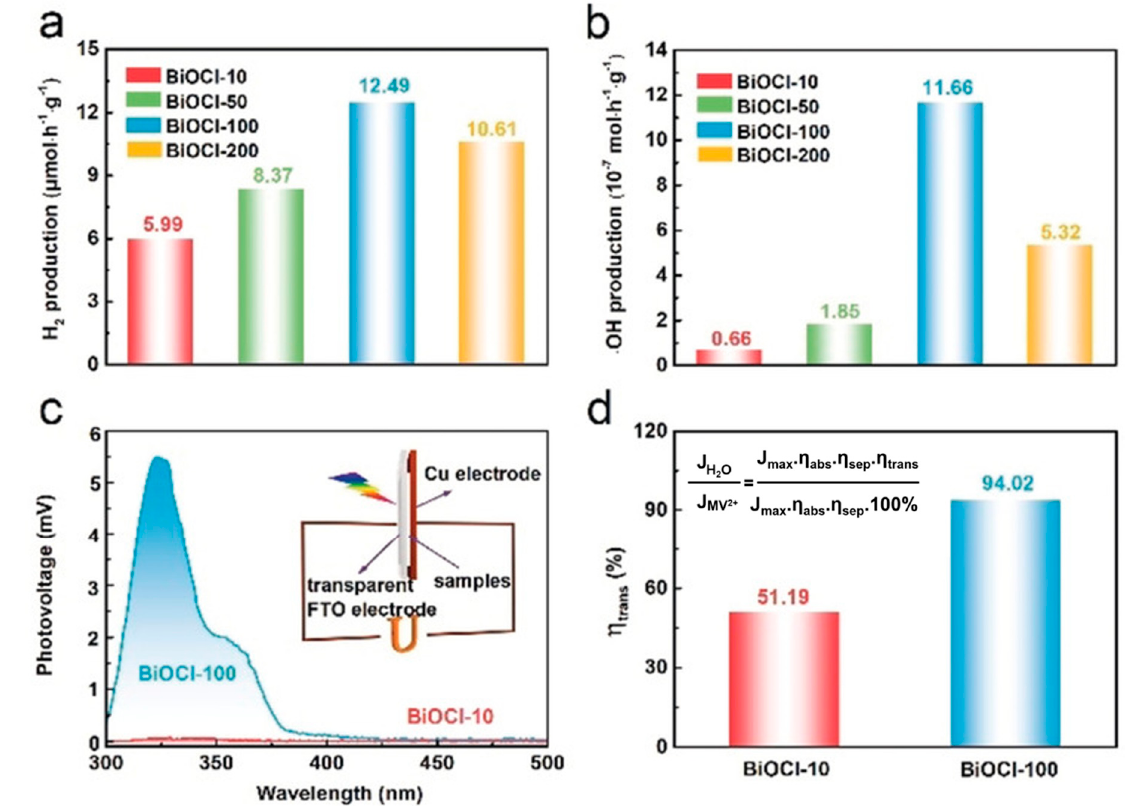
Figure 7. Rate constants for generation of ( a ) H 2 and ( b ) hydroxyl ions over different BiOCl photocatalysts under simulated solar light irradiation. ( c ) Surface photovoltage spectra of BiOCl synthesized with time span of 10 h (BiOCl-10) and 100 h (BiOCl-100) indicating the degree of charge separation. ( d ) Surface charge transfer efficiency of BiOCl-10 and BiOCl-100. Reprinted from Ref. [192] with permission from John Wiley &